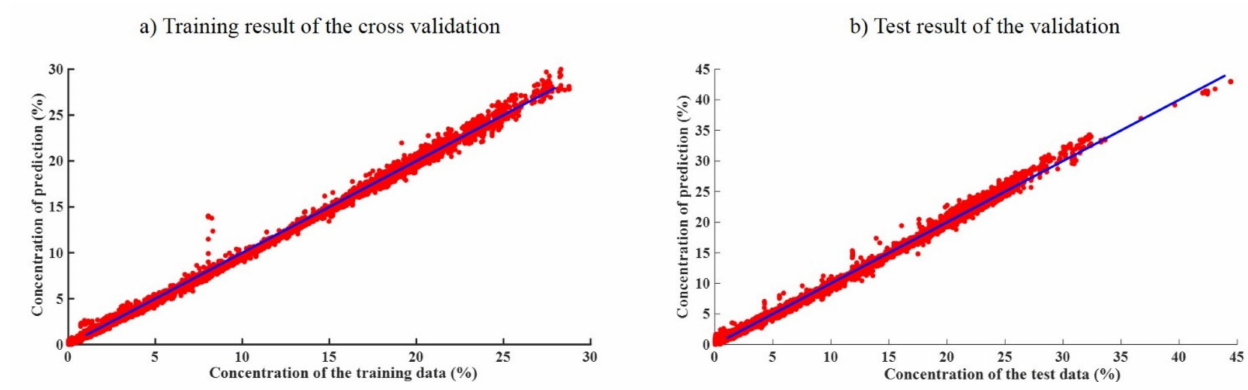
Figure 11. The learning result of cross validation.